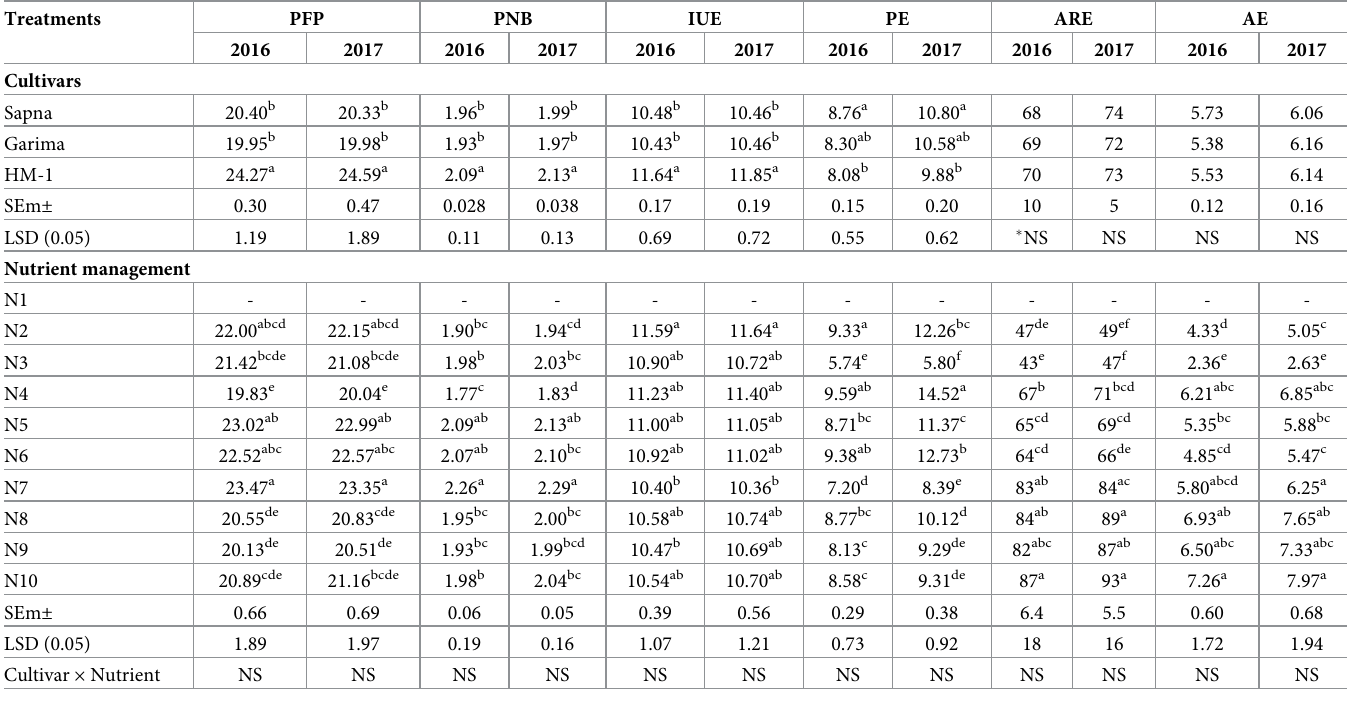
Table 3. Effect of cultivars and nutrient management practices on nutrient use efficiencies (kg kg -1 ) for cumulative NPK. Treatments PFP PNB IUE PE